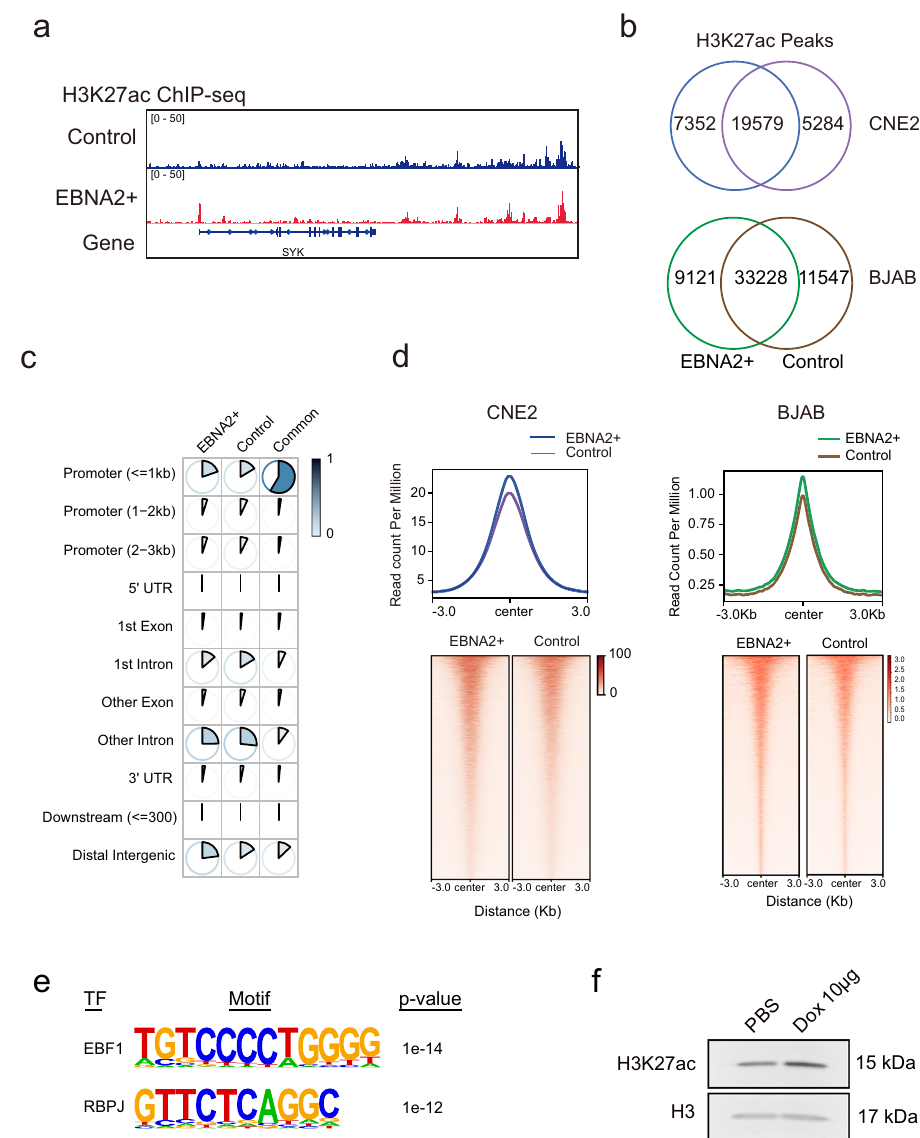
Fig. 7 ENBA2 promoted the acetylation of the histone H3K27 in genome-wide. a ChIP-seq tracks of H3K27ac in the Dox-induced EBNA2 + CNE2 cells (blue track) and control CNE2 cells (purple track). b Venn diagram of H3K27ac peaks in the Dox-induced EBNA2 + CNE2 cells (green track) and control CNE2 cells (brown track), EBNA2 + BJAB cells (green track), and control cells (brown track) c Annotation of H3K27ac peaks. EBNA2 + : EBNA2 + cell unique peaks, control: control cell unique peaks, common: peaks of overlapped in both cell types. d The plot and heatmap of common peaks in the Dox- induced EBNA2 + cells (blue track) and control cells (purple track), EBNA2 + BJAB cells (green track), and control cells (green track). e Selected transcription factor binding motifs overrepresented in CUT&Tag peaks, the most enriched factor for each family is shown. f Western blot of H3K27ac of the EBNA2-expressing HEK 293T cells treated with 10 μ g/mL Doxycycline or vehicle for 24 h. H3 served as a loading